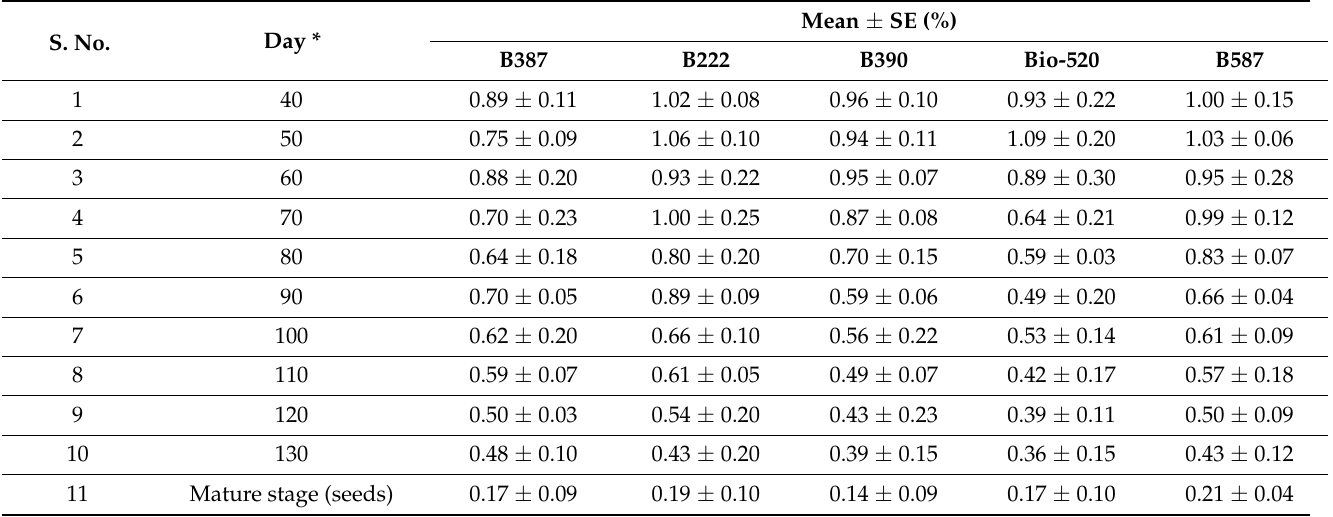
Table 1. Total ODAP content (%) in different plant development stage in L. sativus during the year